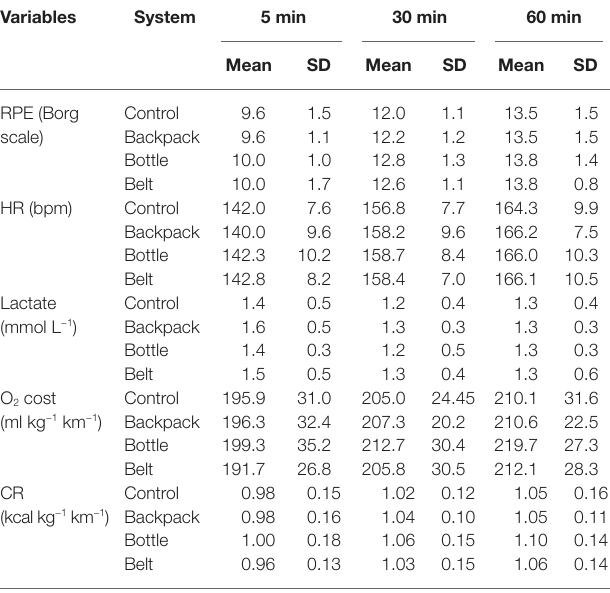
TABLE 2 | Means and SD for different systems per measurement time for the group of runners. Variables System 5 min 30